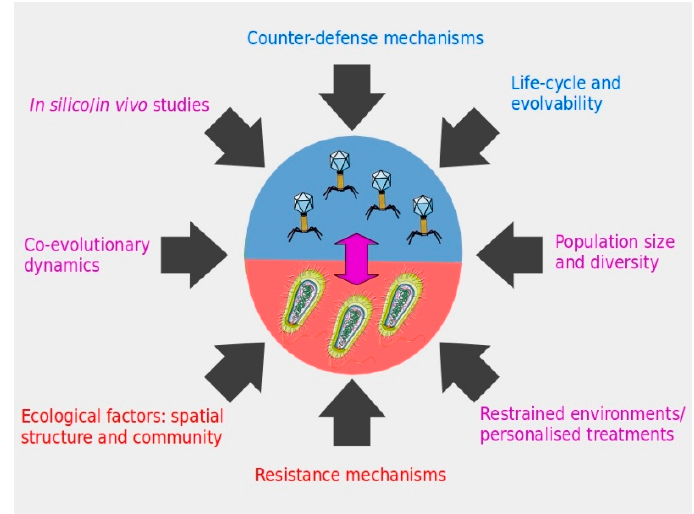
Figure 1. Different factors to consider in phage therapy applications in order to ensure the durability of the strategy against pathogenic bacteria. Color code associates the factors to therapeutic phages (blue), the targeted bacteria (red), or both microorganisms and the interaction between them